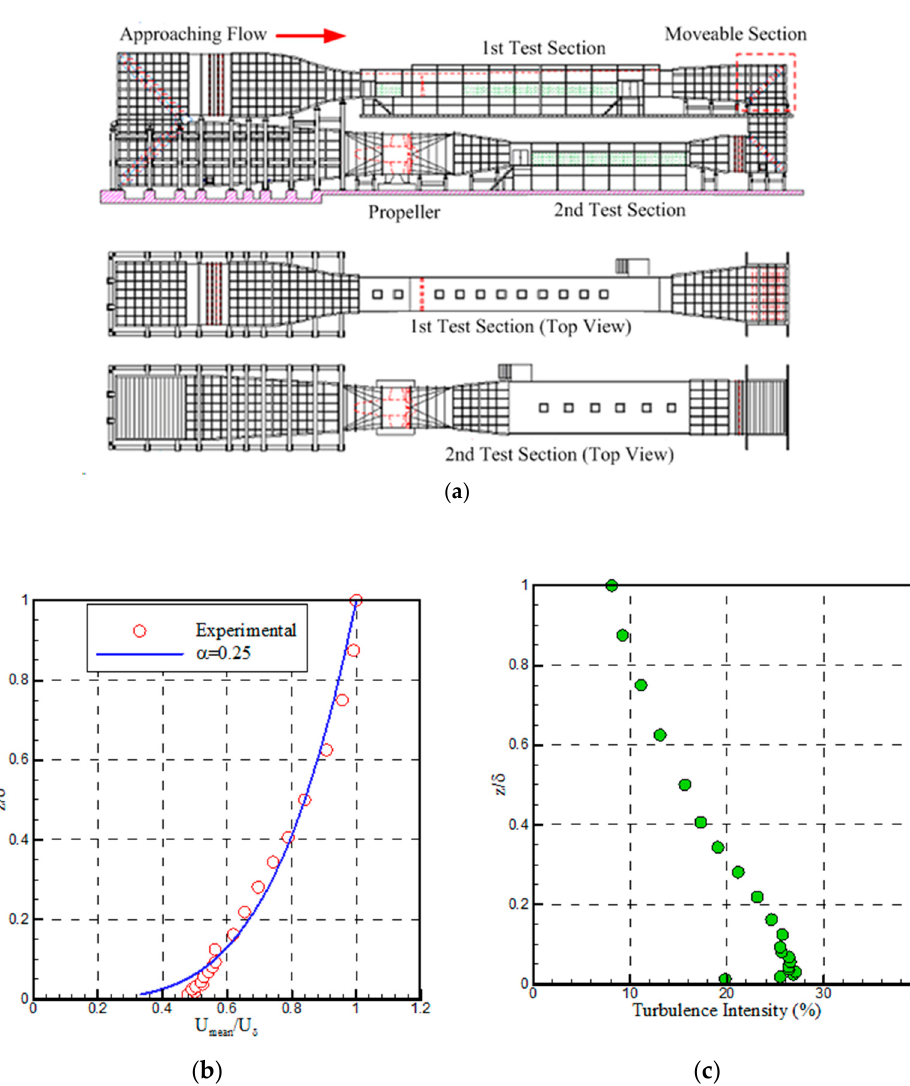
Figure 4. Wind-tunnel diagrams and approaching wind profile in wind-tunnel [2]. ( a ) Schematic (left) and photo (right) wind-tunnel; ( b ) mean speed profile; ( c ) mean speed profile.